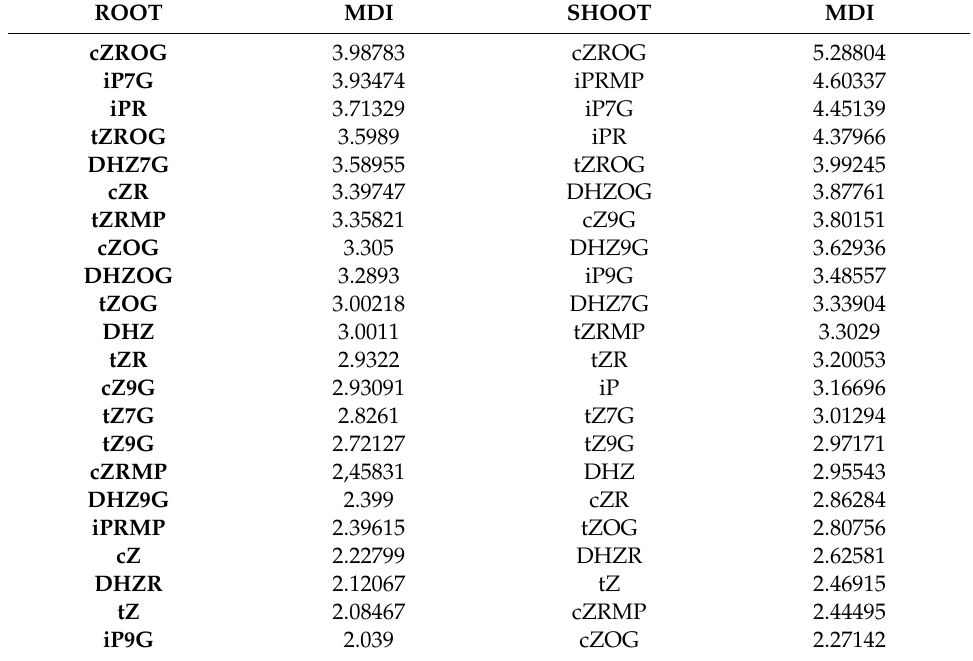
Table 3. The importance of various cytokinin derivatives in root and shoot as trait variables for classification based on the Mean Decrease in Impurity value (MDI). The most important compounds are on the top of the list. Abbreviations: trans -zeatin ( t Z), trans -zeatin riboside ( t ZR), trans -zeatin- O -glucoside ( t ZOG), trans -zeatin- O -glucoside riboside ( t ZROG), trans -zeatin N